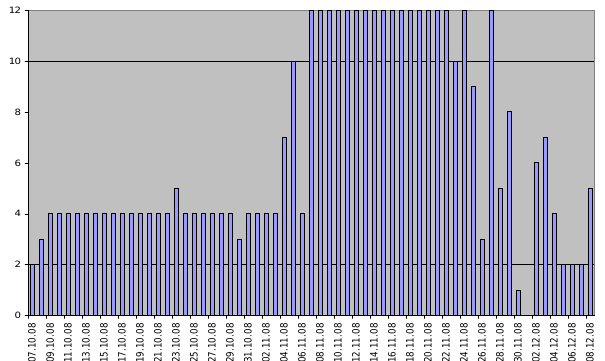
Fig. 7. Number of successfully received transmissions of initially 4, later 12 initiated transmissions per day (plus additional manually triggered transmissions). Energy supply problems of the OBU-BU lead to decreasing success after 1